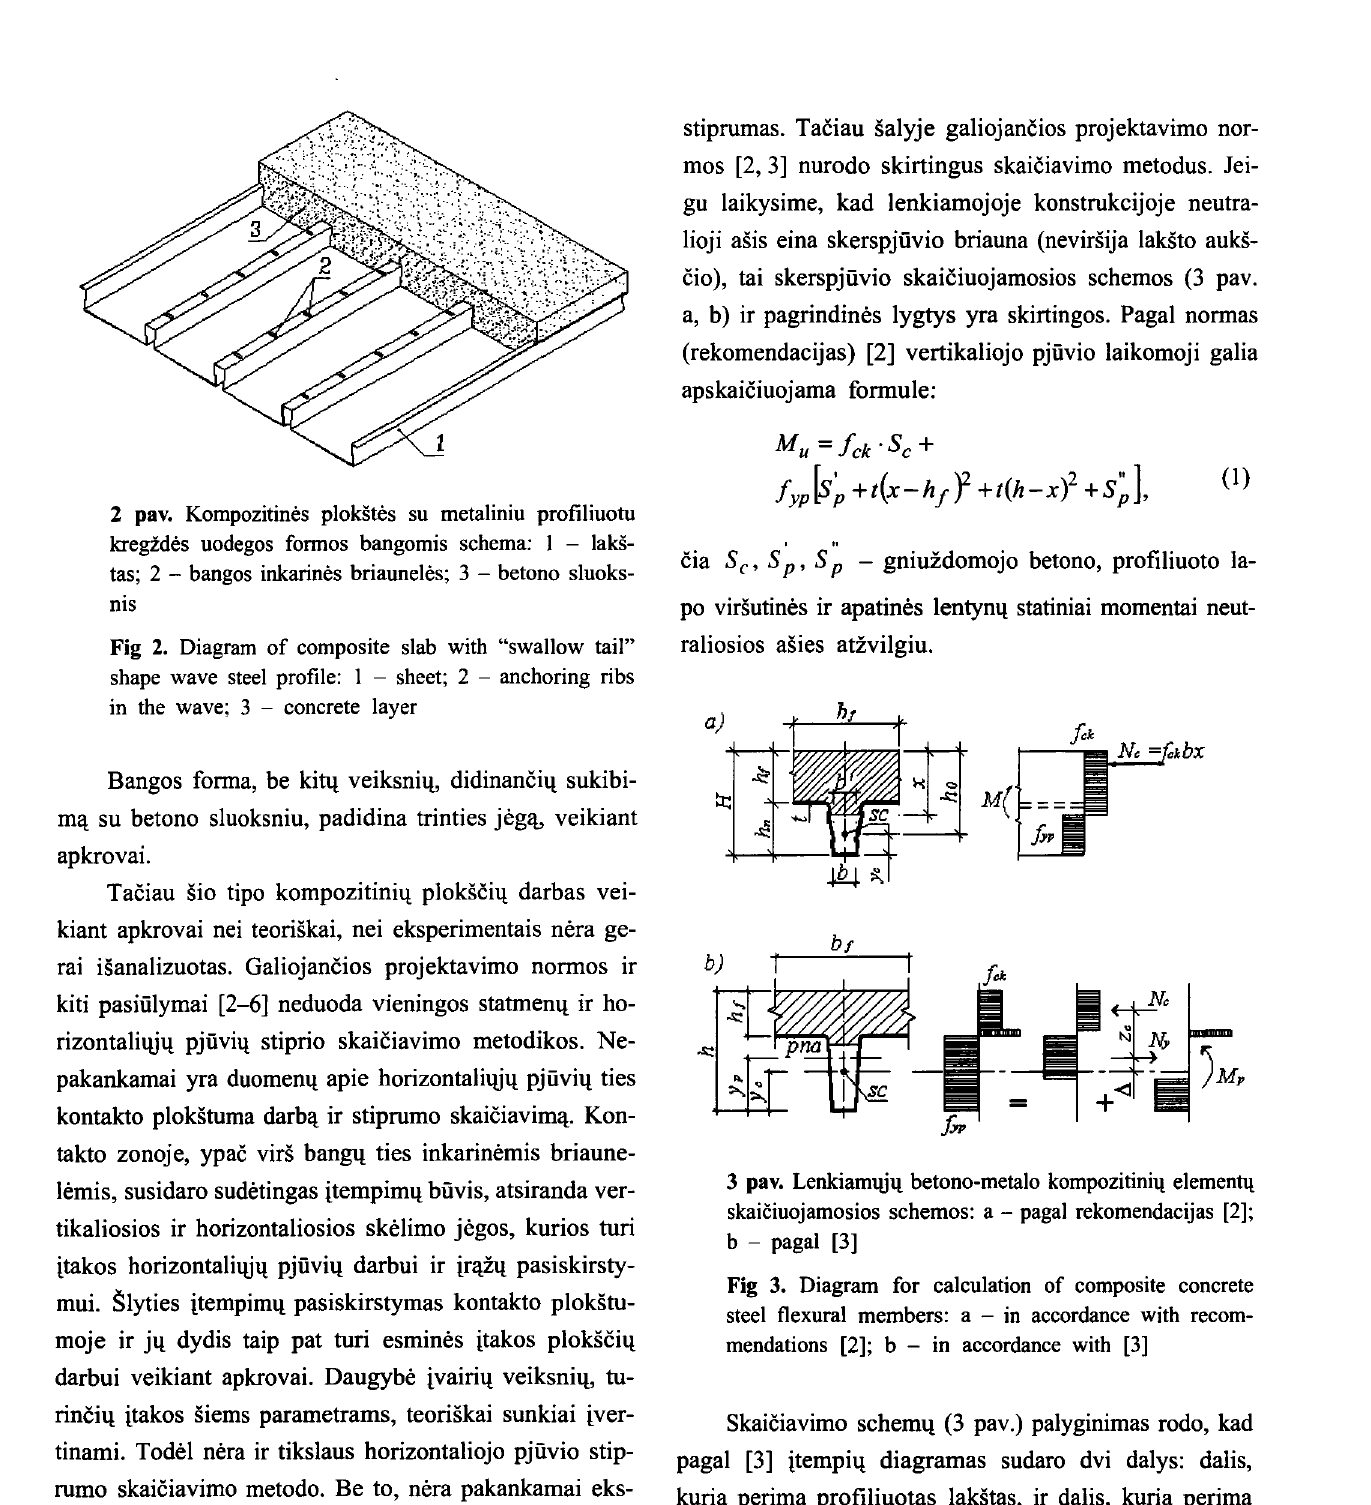
Fig 3. Diagram for calculation of composite